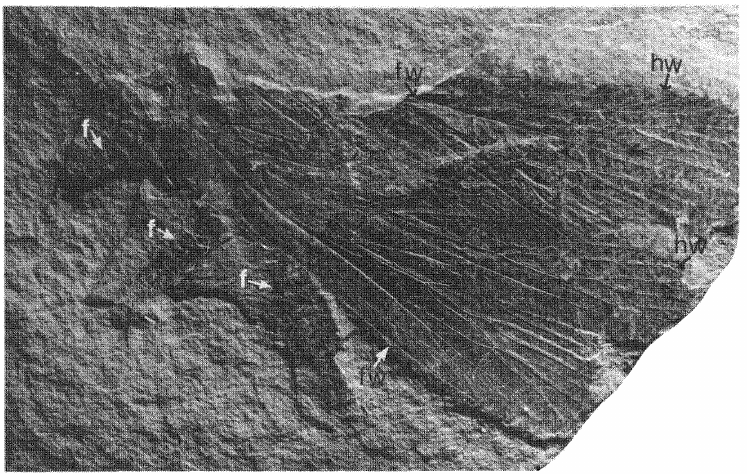
Fig. 16. Gerarus.lscheri, photograph of IP 7. Length of fore wing 50 mm. femur; fw fore wing; hw hind